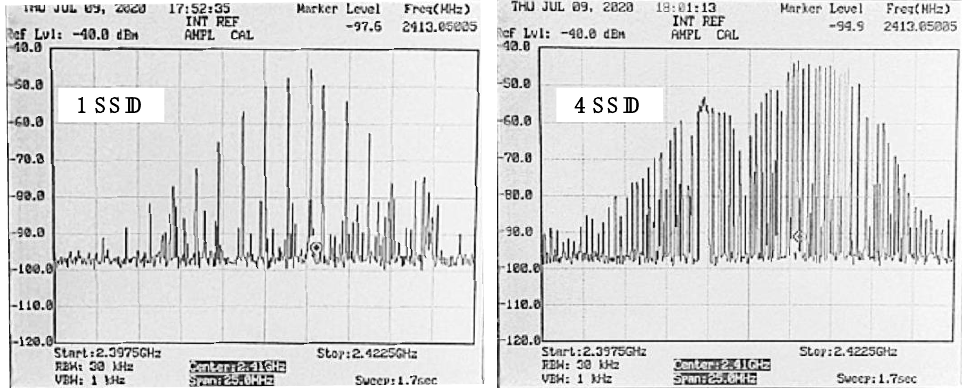
Figure 6. Spectrum analyzer WiFi signal measurement for 1 and 4 SSIDs routers.